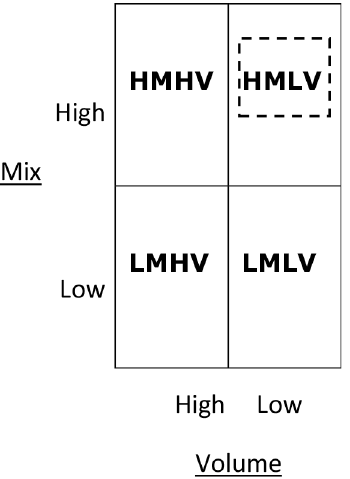
Figure 3. Manufacturing Type